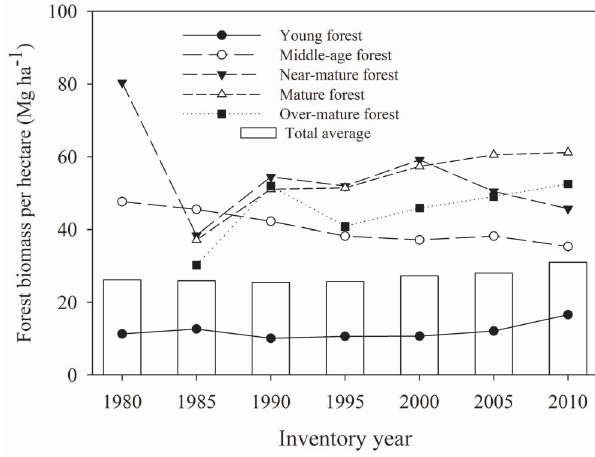
Figure 6. Changes in forest unit-area biomass carbon in Liaoning province in the period of